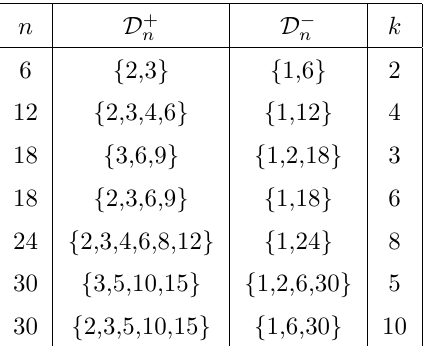
Table 3 . All solutions for N A = 2 and n (cid:20) 30 of the D k +2 family. They are de(cid:12)ned by n ((cid:12)rst column) and the set D + (second column), from which one gets (cid:8) + n column is for completeness, and it is unique due to (3.19). The last column speci(cid:12)es the integer k of the solution